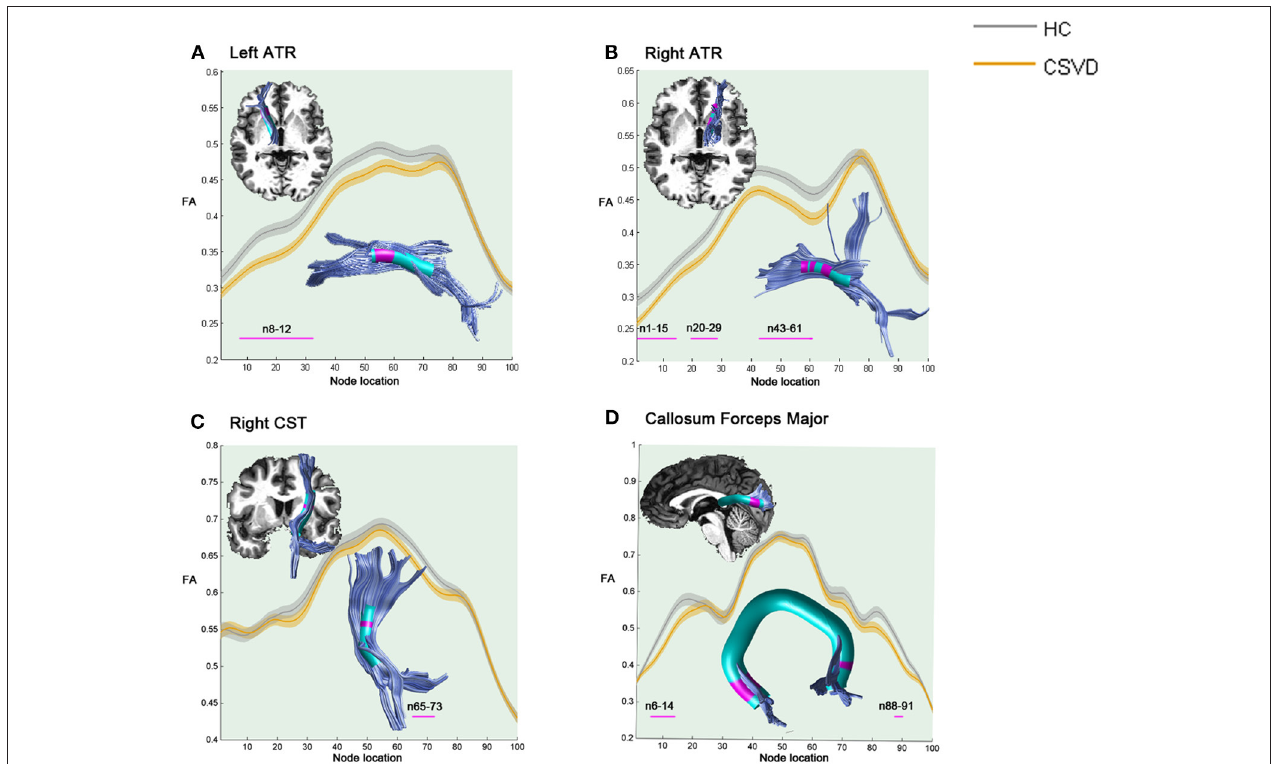
FIGURE 1 | Significantly damaged locations of fiber tracts between the HC and CSVD groups in the pointwise comparison of FA profiles (FWE correction, p < 0.05). The blue line indicates the HC group, the orange line indicates the CSVD group, the shadows represent the confidence interval, and the pink fiber segments are the position of the fiber segment that is different between the groups. (A) Significantly decreased FA values in the anterior component of the left ATR (nodes 8–32) in CSVD group. (B) Significantly decreased FA values in the anterior and intermediate components of the right ATR (nodes 1–15; nodes 20–29; and nodes 43–61) in CSVD group. (C) Significantly decreased FA values in the superior portion of the right CST (nodes 65–73) in CSVD group. (D) Significantly decreased FA values in the occipital lobe portions of the callosum forceps major (nodes 6–14 and nodes 88–91) in CSVD group. HC, health control; CSVD, cerebral small vessel disease; FA, fractional anisotropy; ATR, anterior thalamic radiation; CST, corticospinal tract.